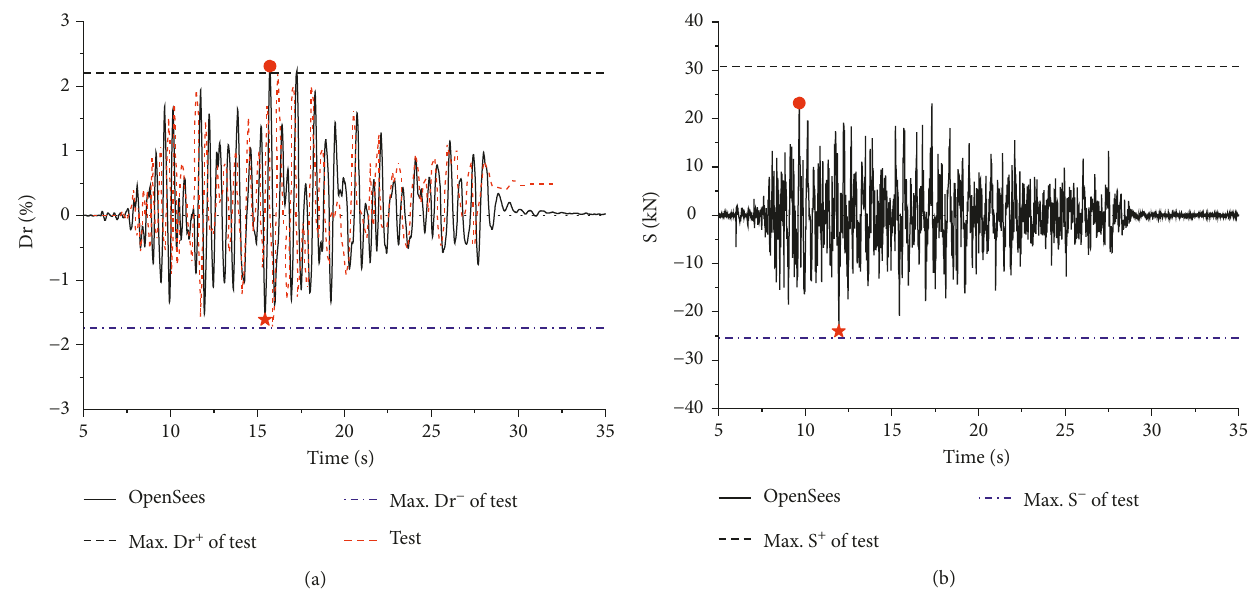
Figure 6: Comparison of analytic model and test for specimen ST 1-b. (a) Drift ratio. (b)